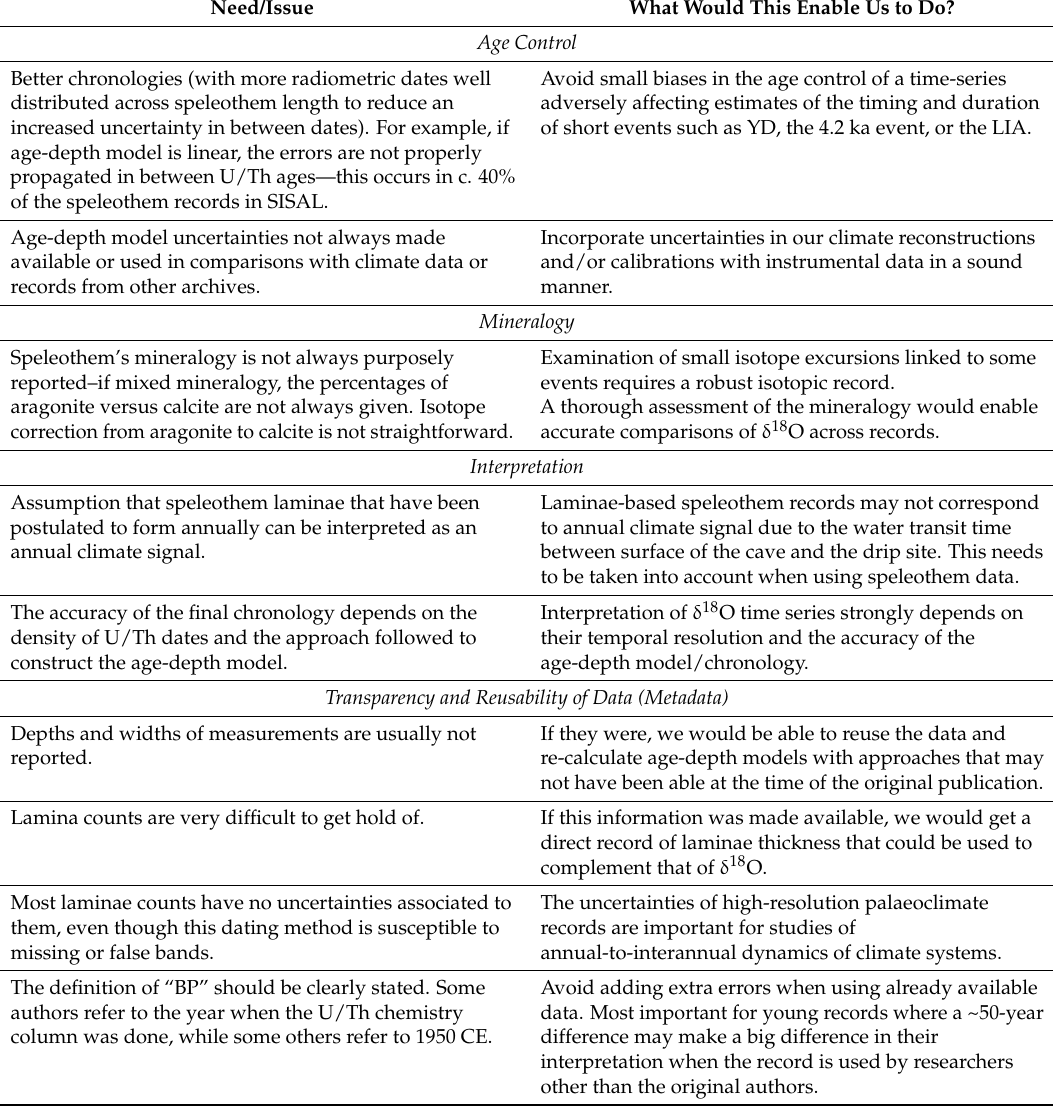
Table 1. Summary of opportunities for improvement identified during the construction and consequent analyses of the SISAL